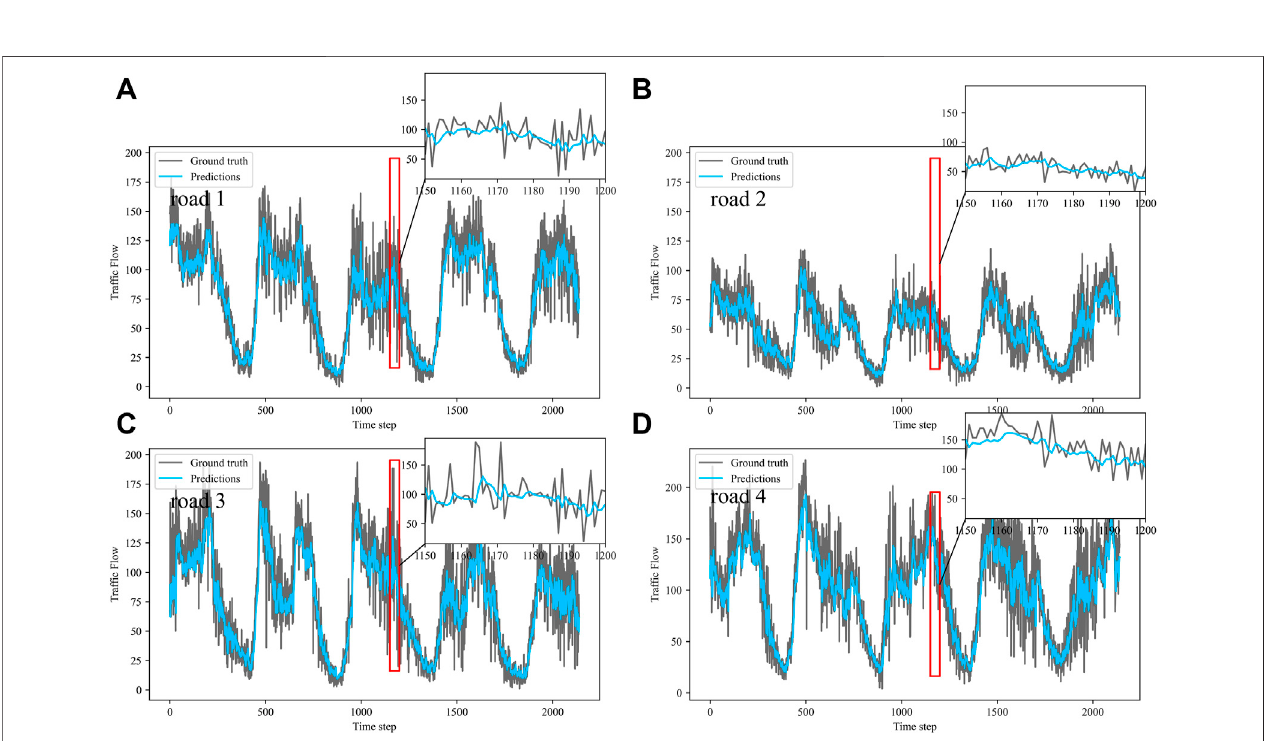
FIGURE15| VisualizationofGruGcnmodelpredictionresultsonthecompletedataset. (A) road1meansGudunRoad. (B) road2meansFengtanRoad. (C) road3 means Yile Road. (D) road 4 means Jingzhou Road.